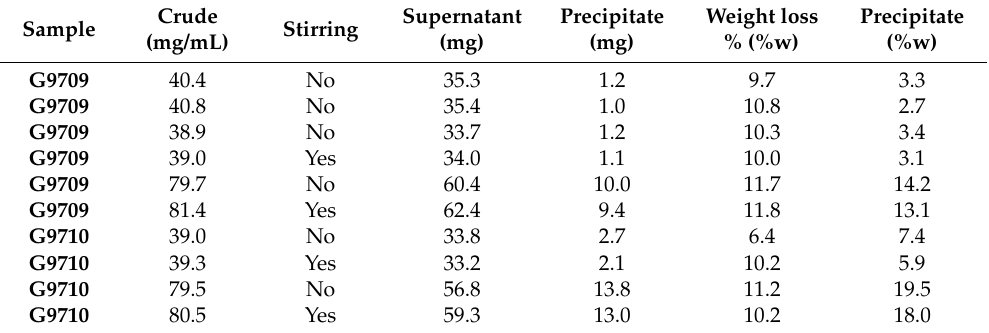
Table 1. Recovering of soluble and insoluble material obtained by two crude heparin samples. Weightings before and after the separation and lyophilization procedure are